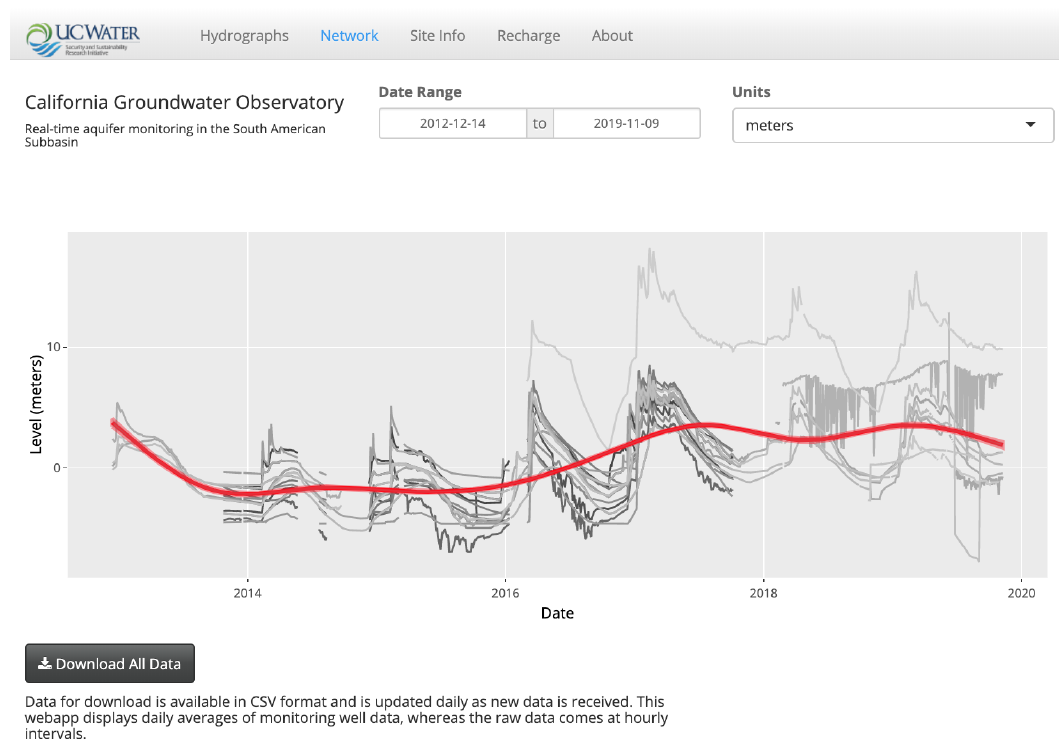
Figure 5. The network tab of the GWO shows all monitoring well data, and allows for a more complete picture of the system state. A button is provided for data download.